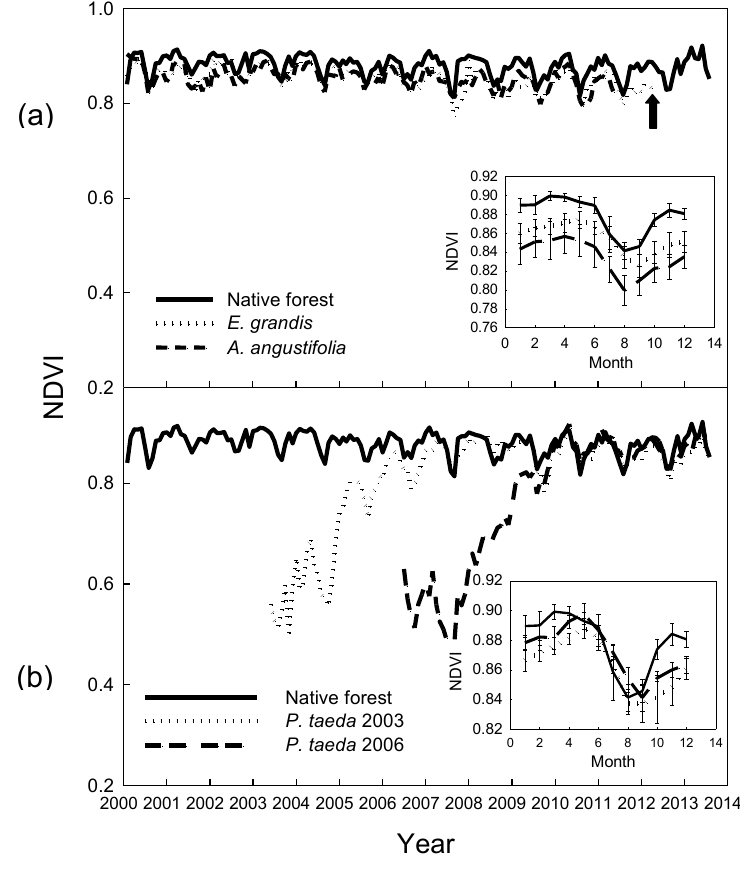
Figure 2. Monthly MODIS NDVI from 2000 to 2013 of ( a ) a native forest and tree plantations of Eucalyptus grandis and Araucaria angustifolia and ( b ) a native forest compared with two tree plantations of Pinus taeda planted in different years. Inset: annual dynamic of NDVI obtained from the monthly averages of the: 2000 to 2013 time series for the native forest, 2000 to 2012 for E. grandis and A. angustifolia , and for 2009 to 2013 for both P. taeda species. Numbers 1 through 12 in the X -axis insets correspond to January through December. Bars indicate the 95% confidence intervals. Arrow indicates the time when E. grandis plantation was harvested.